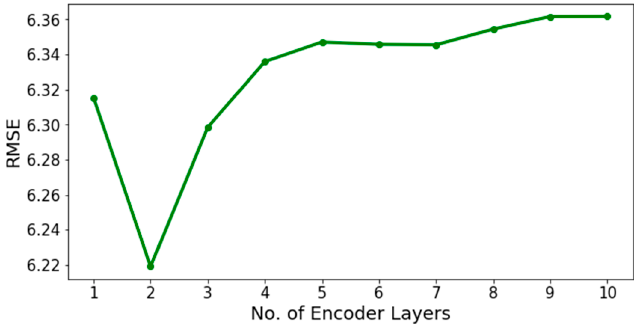
Figure 7. Selecting the optimal number of AE’s encoder hidden layers based on RMSE.